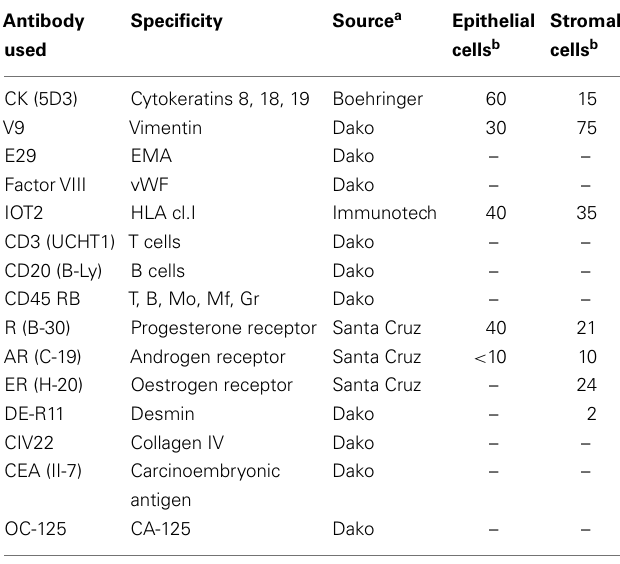
Table 1 | Phenotype of endometriotic cell cultures